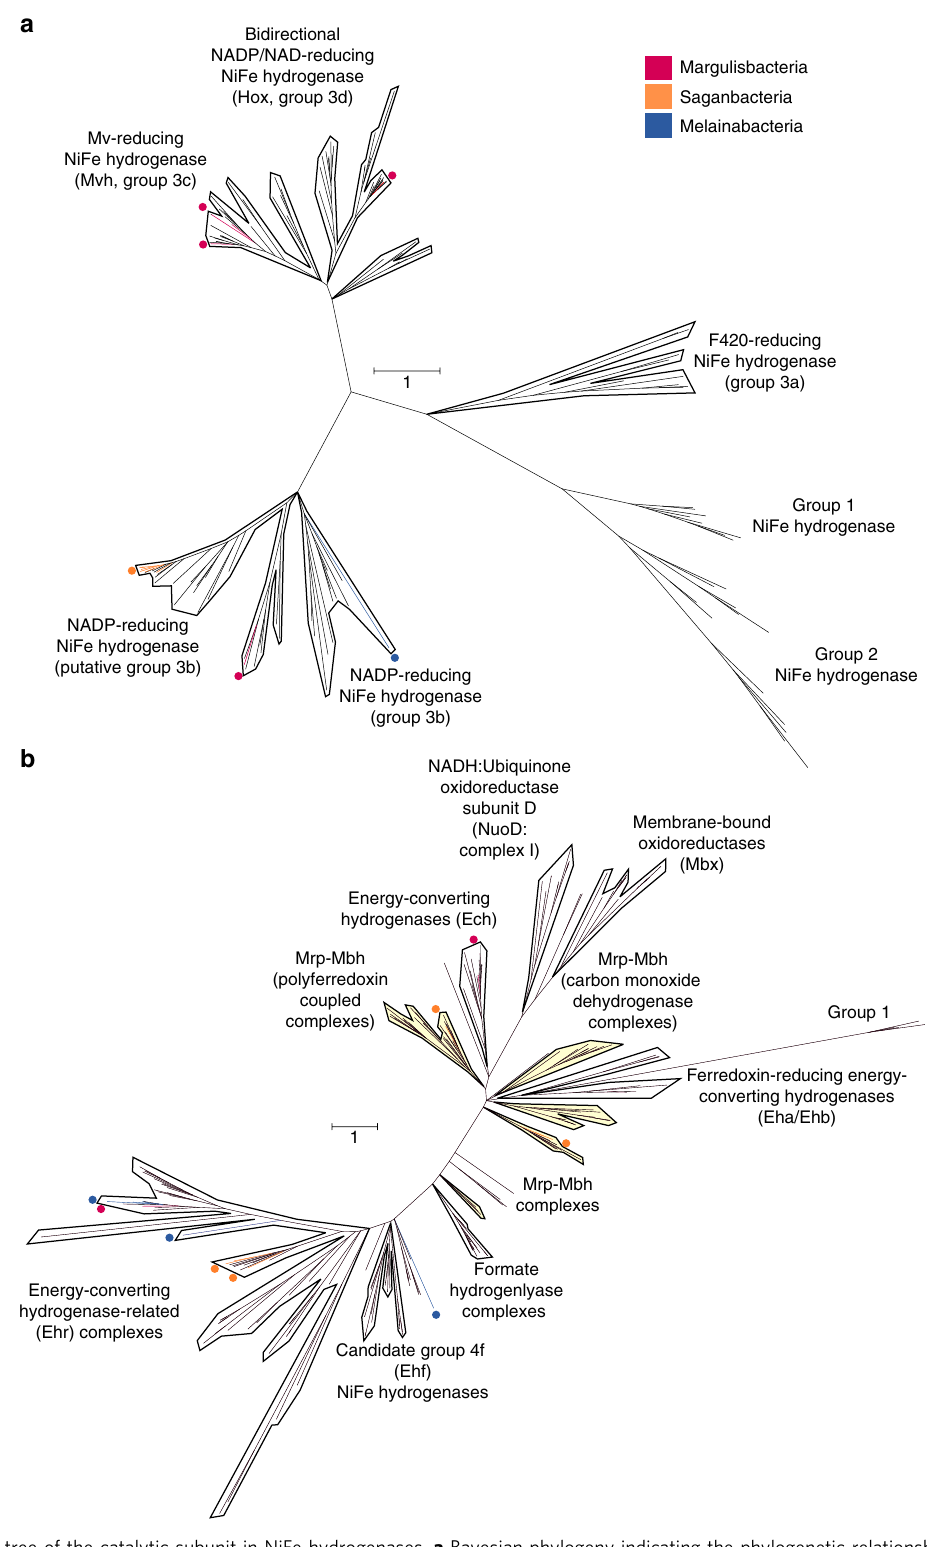
Fig. 4 Phylogenetic tree of the catalytic subunit in NiFe hydrogenases. a Bayesian phylogeny indicating the phylogenetic relationships of the Ri fl emargulisbacteria, Saganbacteria, and Melainabacteria groups 1, 2 and 3 NiFe hydrogenase catalytic subunits and b Bayesian phylogeny indicating the phylogenetic relationships of the Ri fl emargulisbacteria, Saganbacteria, and Melainabacteria group 4 NiFe hydrogenases and related complexes. Scale bar indicates substitutions per site. Branches with a posterior support of below 0.5 were collapsed. The tree and underlying alignments are available with full bootstrap values as pdf and in Newick format in Supplementary Data 5-8 and